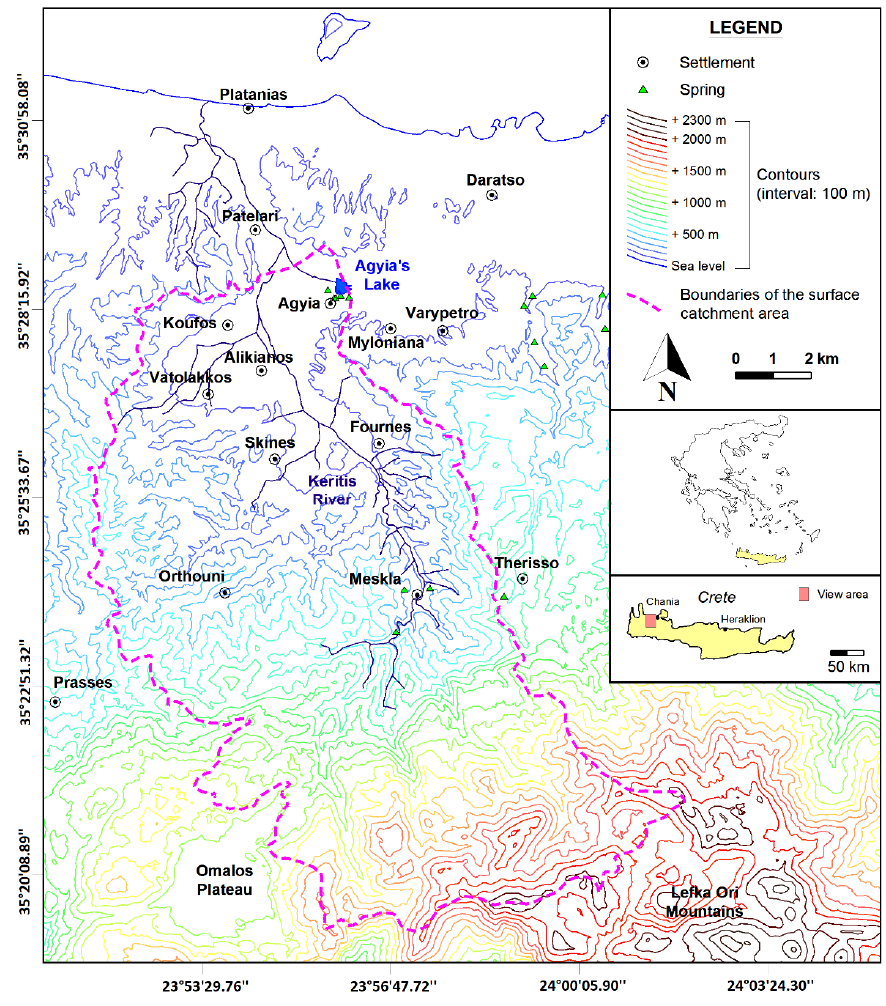
Figure 1. Springs catchment